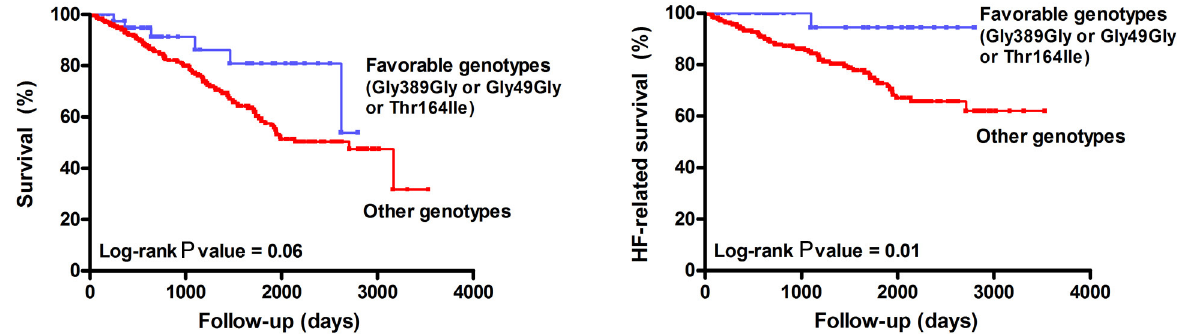
Figure 2. Kaplan-Meier survival curves for all-cause mortality (N = 315, left) and heart failure (HF)-related mortality (N = 315, right) according to the combination of “favorable” adrenergic receptor genotypes. Favorable genotypes include Thr164Ile and/or Gly49Gly and/or Gly389Gly patients.